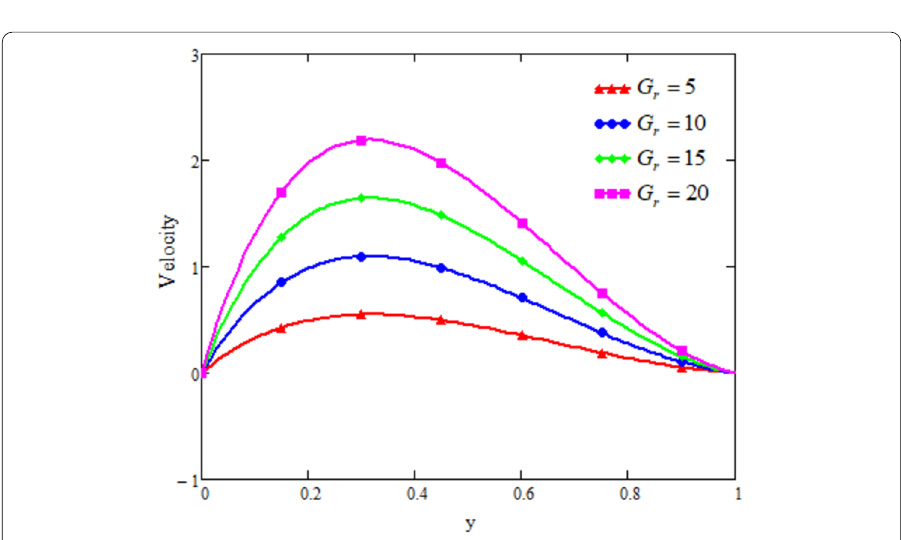
Figure 7 Velocity curves along G r variation and α = 0.5, P r = 11.5, K = 3.5, λ = 0.4, λ 1 = 1.6, H a = 0.8, t =